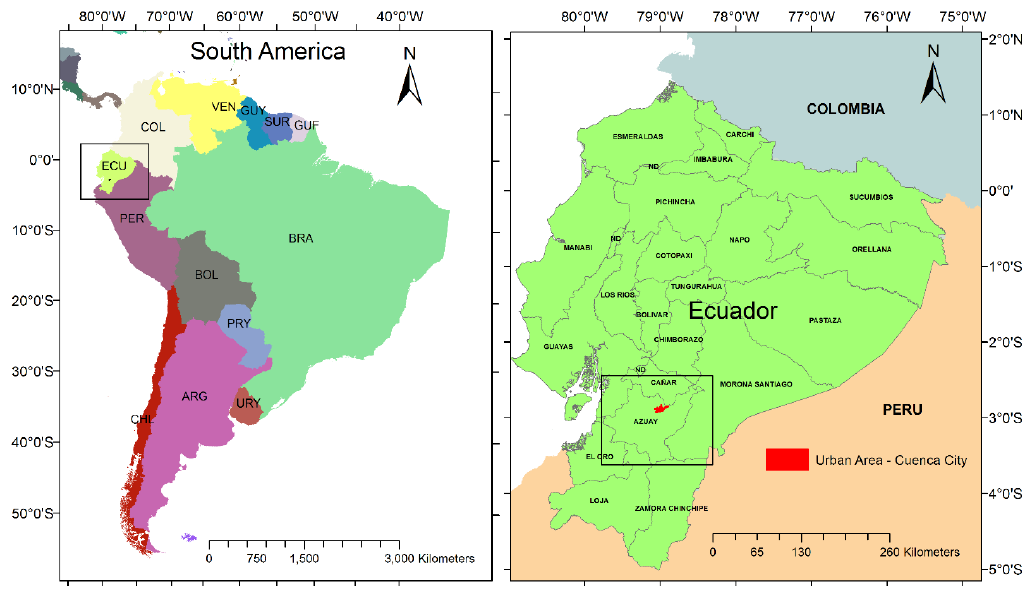
Figure 1. Study area Cuenca City, Ecuador.